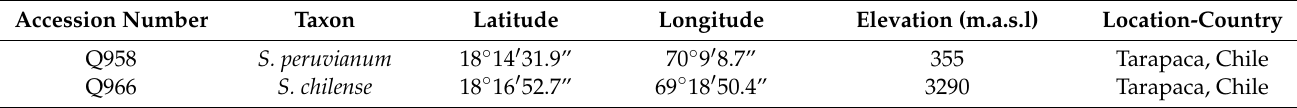
Table A1. Passport information from wild tomato